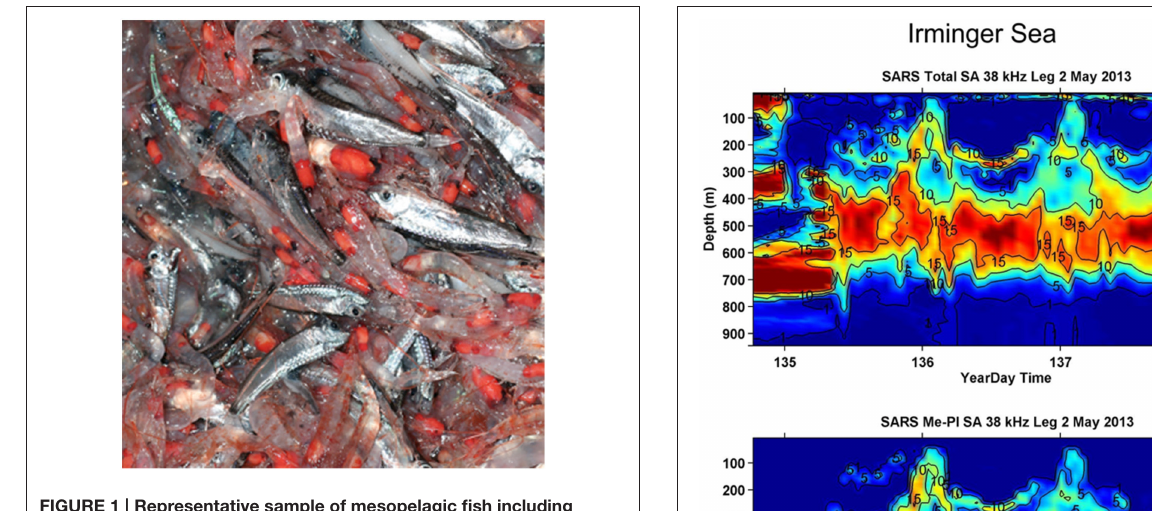
FIGURE 1 | Representative sample of mesopelagic fish including Maurolicus muelleri, Sergestes arcticus, and Benthosema glaciale and plankton e.g., Meganyctiphanes norvegica in the deep scatter layers of the Irminger Sea in November 2013.